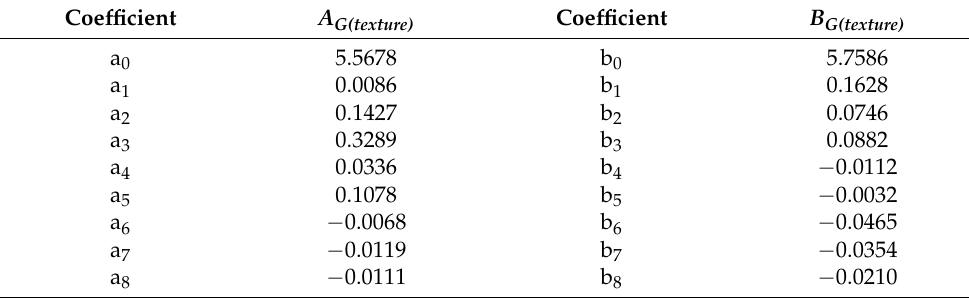
Table 8. Models coefficients for the case with a microtextured surface.